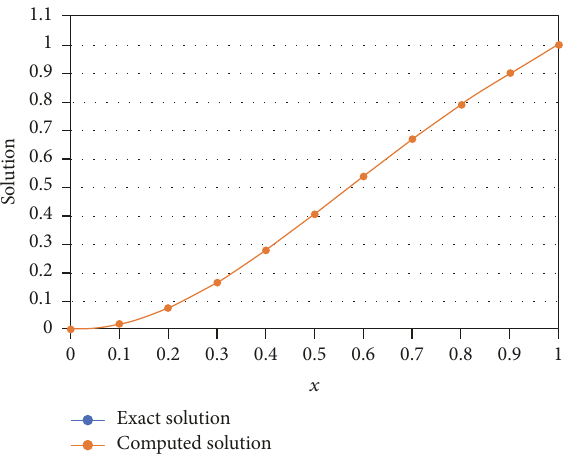
Figure 2: Comparison of the exact and computed solution of Example 8.